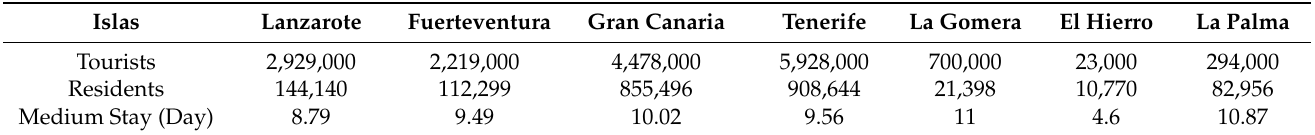
Table 19. Population by island divided into tourists and residents per year